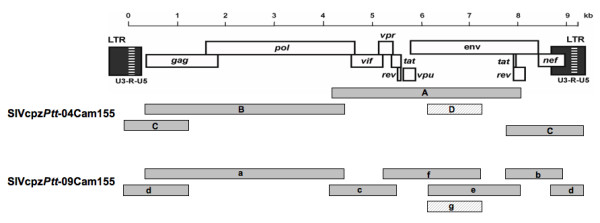
Amplification of SIVcpzPtt-04Cam155 and SIVcpzPtt-09Cam155 full-length genomes. The two full-length genomes were amplified as partially overlapping PCR fragments (shaded boxes) and directly sequenced, except for the V1V4 env regions (hatched boxes) where clonal sequences were necessary. The primers used to amplify each PCR fragment are given in Additional file 2: Table S2. Fragments are drawn to scale and the nucleotide sequences are numbered from the beginning of the R region in the 5' LTR (see scale bar).